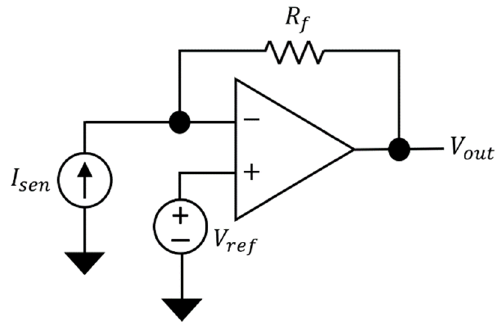
Figure 1. Circuit of conventional resistive Transimpedance Amplifier (R-TIA).